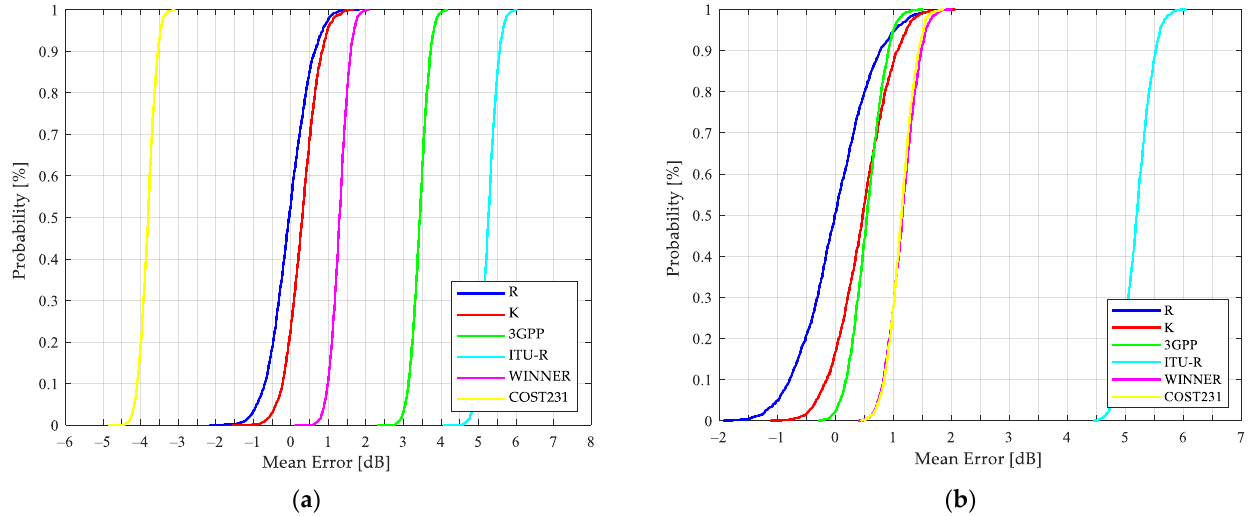
Figure 7. CDFs of mean error for path loss predictions based on different models: ( a ) SS O2I links; ( b ) OS O2I links.